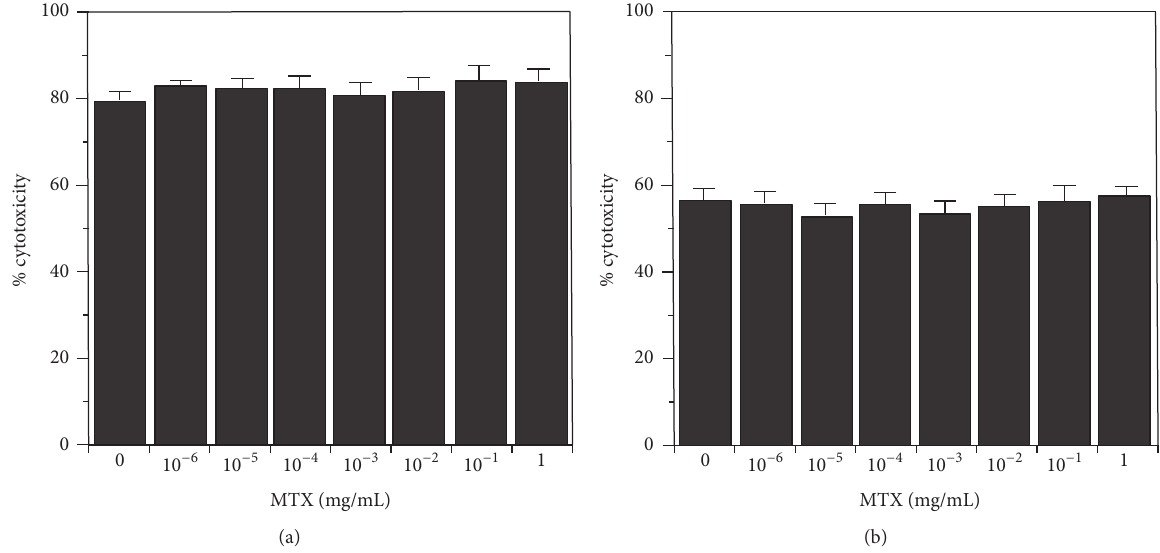
Figure 5: Effect of MTX on TNF- 𝛼 cytotoxicity. AMC were activated by 0.02 𝜇 g/mL LPS in the presence of MTX at various concentrations (1ng/mL–1mg/mL). After overnight culture, cell was washed to remove the LPS and MTX and then subsequently further incubated in the presence (a) or absence (b) of MTX for 24 h to allow TNF- 𝛼 secretion. TNF cytotoxicity in 10x (a) or 5x (b) diluted supernatants was